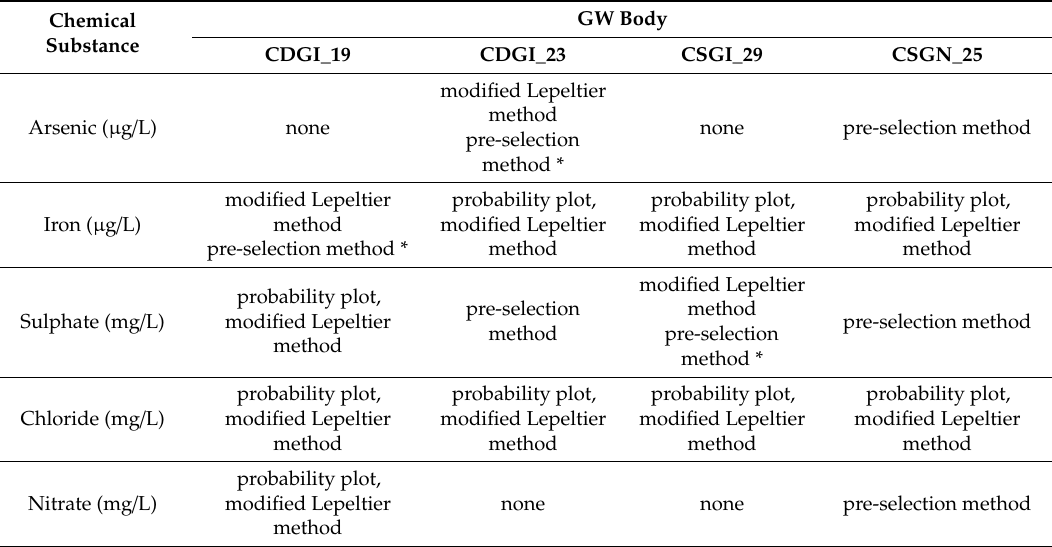
Table 3. Methods selected for calculating the upper limits of ranges of ambient background concentrations of analysed substances based on criteria described in Section 2.3.